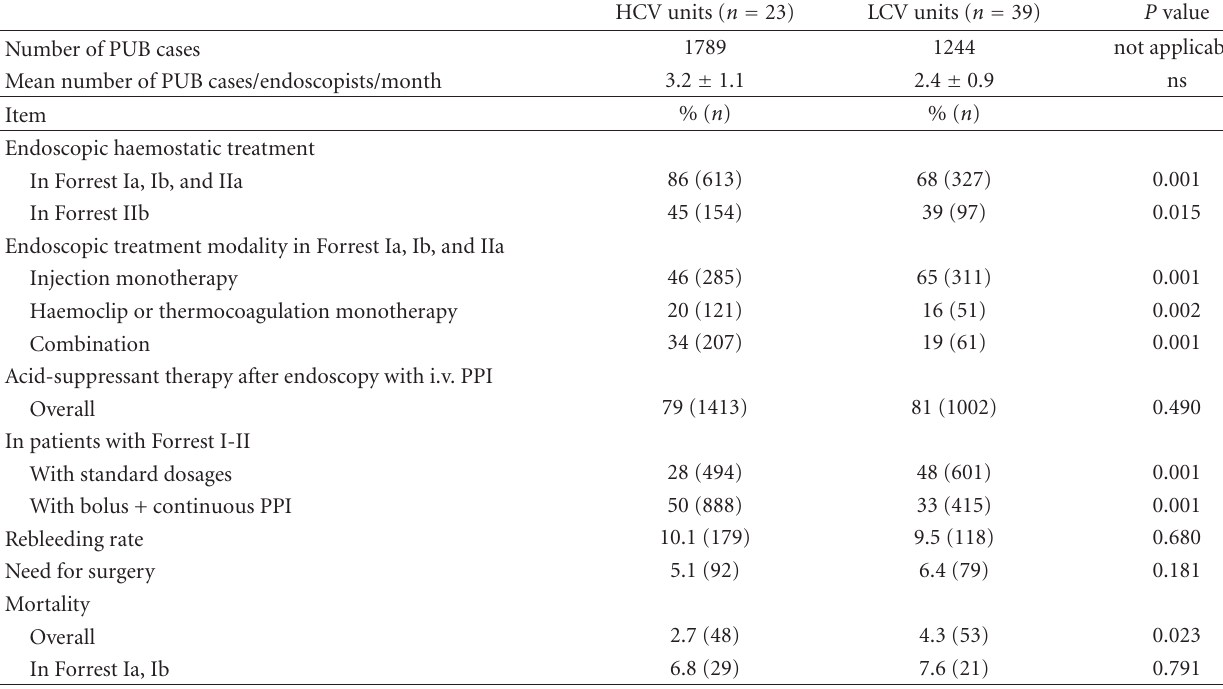
Table 2: Comparison of selected items in high and low case volume